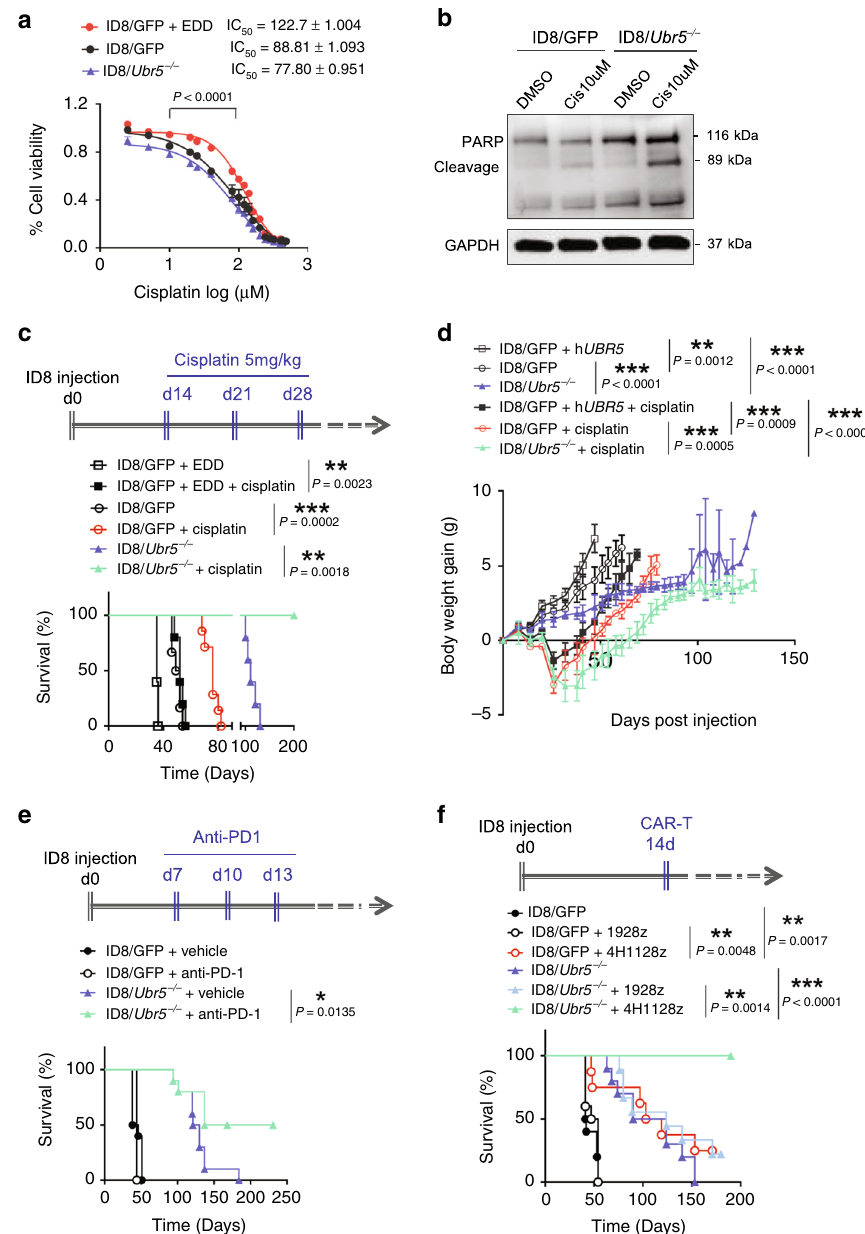
Fig. 8 Enhanced therapeutic bene fi ts in OC by targeting tumor-derived Ubr5 . a Dose response curves of ID8 treated with cisplatin for 72 h ( n = 5 biologically independent samples per group). The averages of three independent experiments were plotted, data are presented as mean ± SD, P < 0.0001, one-way ANOVA test. b Western blot analysis of cleaved-PARP levels after 24 h of cisplatin (Cis) treatment in ID8 cells. c , d UBR5 overexpression abrogated the therapeutic effect of cisplatin treatment. ID8 bearing mice were treated with cisplatin at 2 weeks after tumor implantation once a week for 3 weeks ( n = 5 mice per group). Mouse mortality ( c ) and body weight ( d ) were monitored. Data are presented as mean ± SD, unpaired two-sided Student ’ s t -test. e Anti-PD-1 treatment enhanced the survival of ID8/ Ubr5 − / − bearing mice, but not ID8/GFP bearing mice. Mice were treated with anti- PD-1 at indicated times post tumor implantation, and survival rates were quanti fi ed ( n = 10 mice per group). Data shown is pooled from two independent experiments. f 4H1128z cells administration resulted in long-term survival of mice harboring ID8/ Ubr5 − / − . Mice were treated with CAR-T cells 2 weeks after tumor implantation, and survival rates were quanti fi ed ( n = 10 mice per group). In all cases, data are representative of at least two independent experiments. P values shown in c , e , and f were calculated by log rank test. * P < 0.05, ** P < 0.01, *** P < 0.001. Source data are provided as a Source Data fi